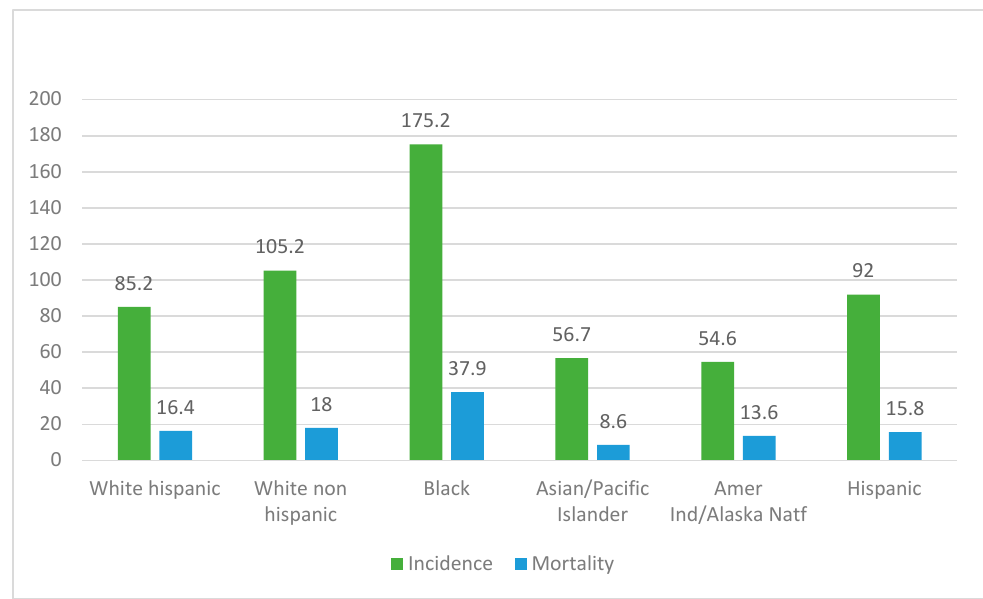
Figure 2. Incidence and mortality rates per 100.000 habitants from SEER prostate cancer registries from 2013 to 2017 in different populations.